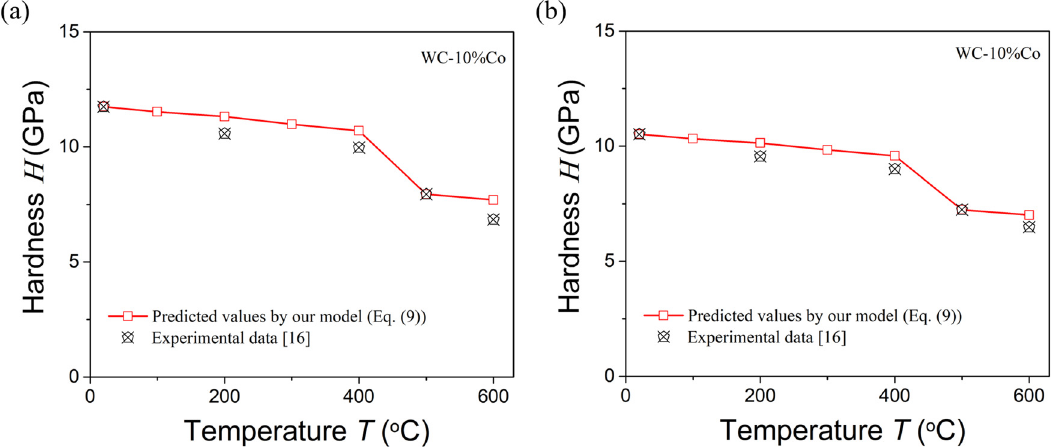
Figure 7: Comparison between the model - predicted and measured hardness of the WC – 10% Co composites at high temperature: ( a ) 0.87 WC – 10% Co composite, ( b ) 0.87 WC – 10% Co composite with pile -